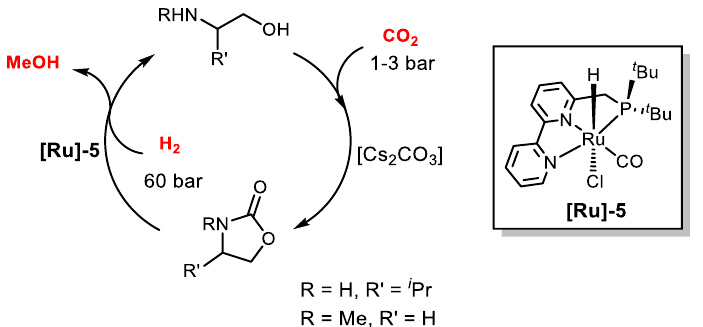
Figure 5. Amino alcohol involved Ru-catalyzed hydrogenation of CO 2 .